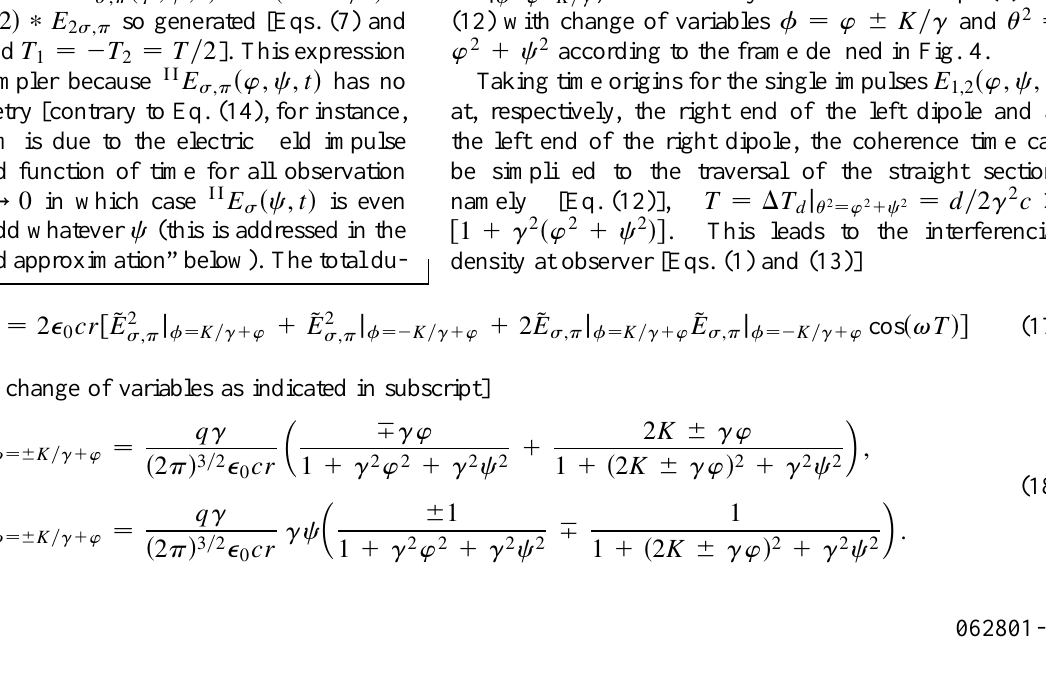
FIG. 3. (Color) Interference between two short dipoles [Eq. (16)]. (a) sin 2 (cid:1) v T (cid:4) 2 (cid:2) modulation pattern. (b),(c) Resulting s and p density distributions, normalized as in Fig. 1; the right-hand SR peaks are damped by bout 0.08 with respect to the left-hand SR peaks. angular coordinate w . Figure 4 also shows typical